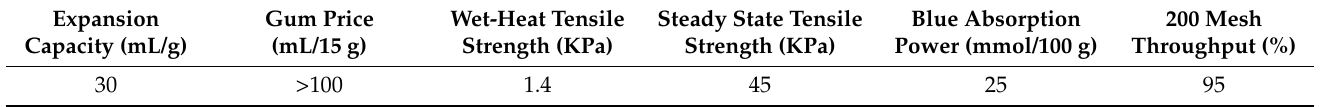
Table 2. Sodium bentonite properties.